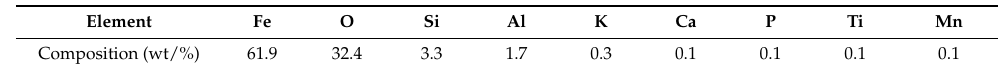
Table 5. XRF analysis of